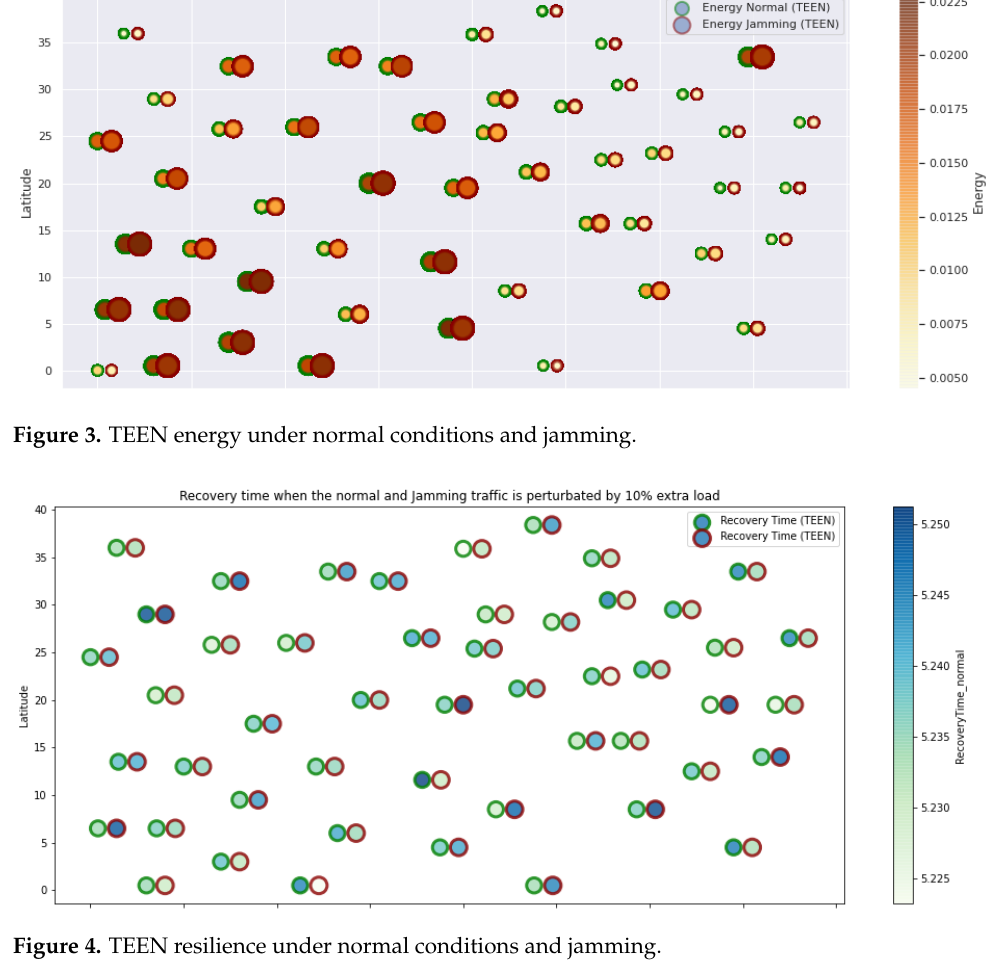
Figure 4. TEEN resilience under normal conditions and jamming.